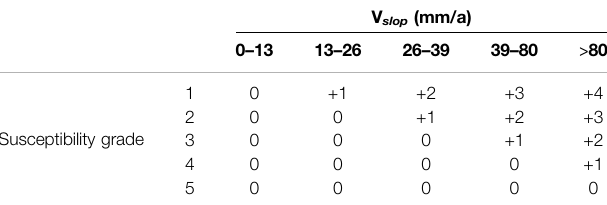
TABLE 3 | Integration of landslide susceptibility and deformation